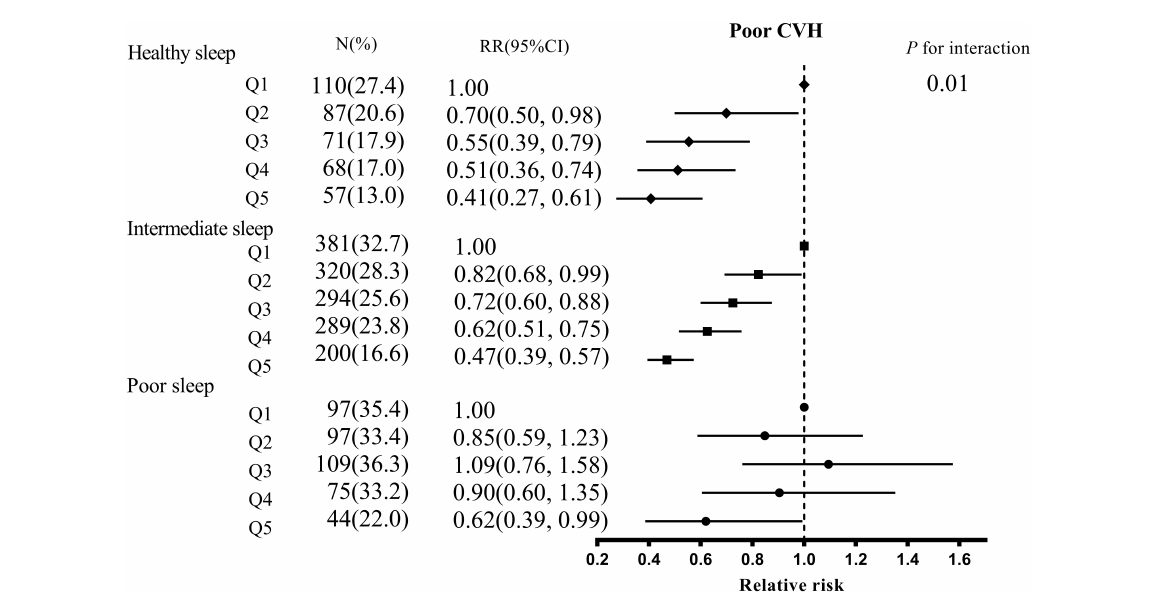
high serum 25(OH)D concentrations appeared to be attenuated among participants with poor sleep